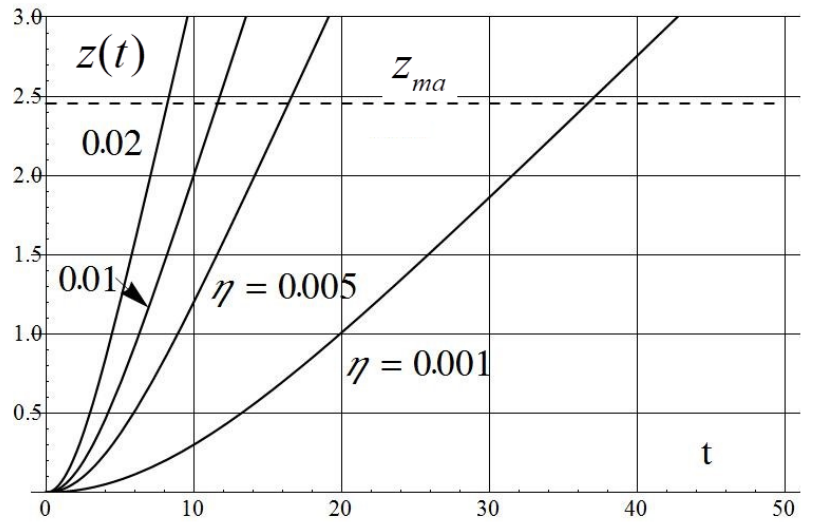
Figure 3. Submersion of a sphere versus time in accelerated motion for an instantaneous change in buoyancy ( t 0 = 0 ) and various η , ds = 0.25 m.